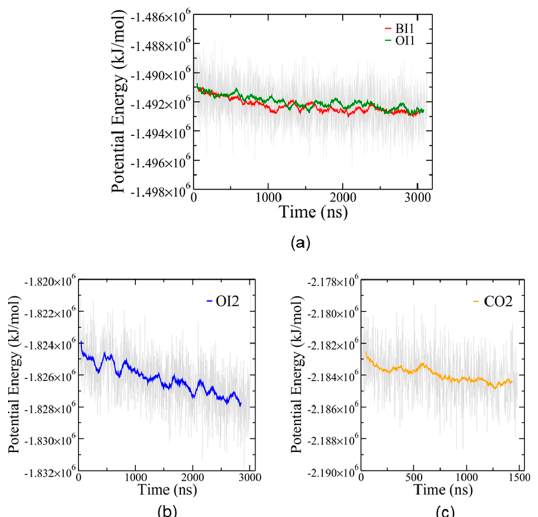
Figure 3. Potential energy for the four simulations. ( a ) BI1 (red) and OI1 (green). ( b ) The first 3 µ s of OI2 (before the temperature increase). The full potential energy plot for OI2 is shown in Supplemental Figure S2. ( c ) CO2. Coloured lines represent running averages over 50 points while grey indicates individual time steps spaced 2 ns apart.